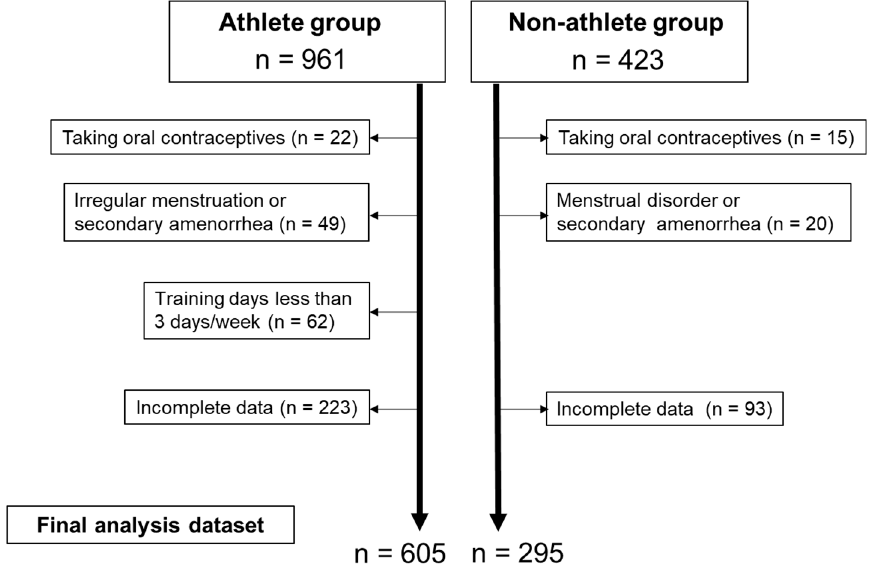
Figure 1. Participant flow diagram.